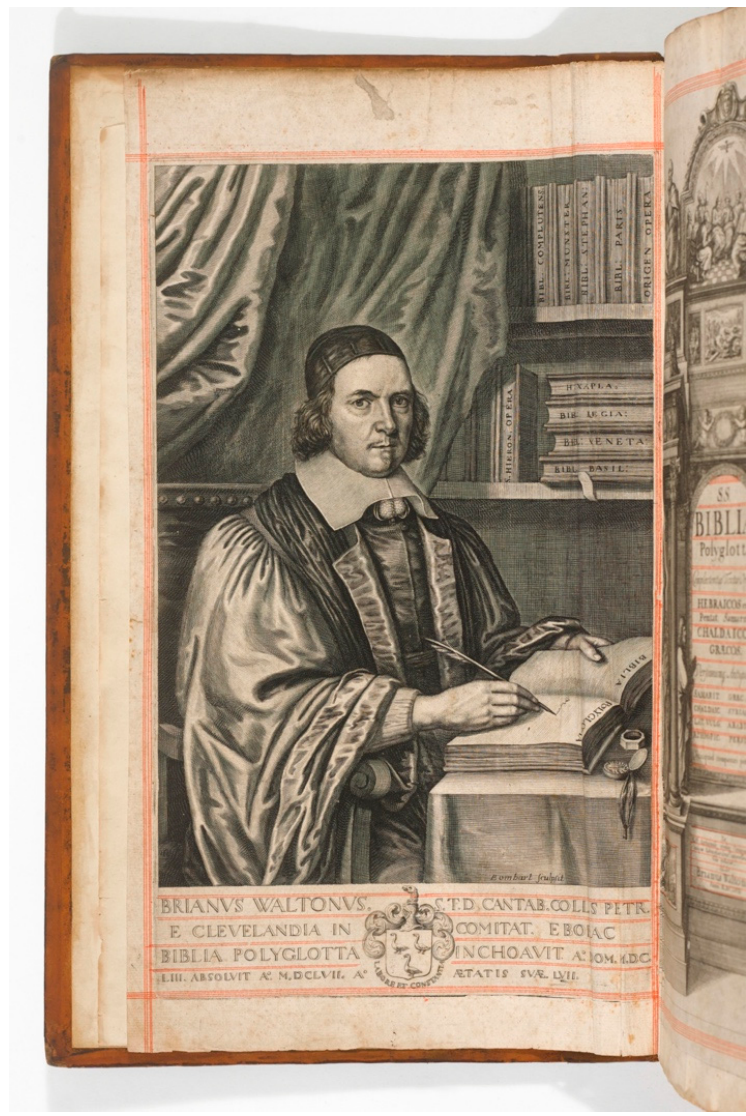
Figure 13. Image of Brian Walton, from Walton Polyglot; Marsh’s Library A.2.2 (Stillingfleet collection).